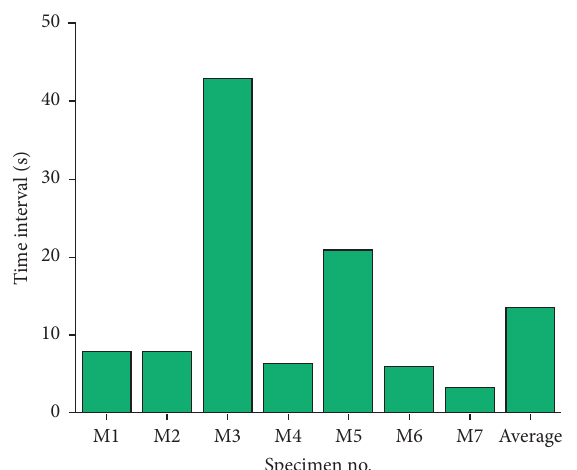
Figure 10: Time intervals between the precursory indicator and failure moment. Table 2: Ratios of the precursory indicator to failure moment in time and force. Specimen no.